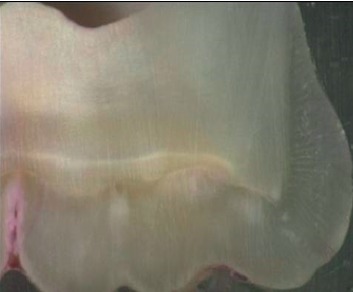
Delimitation of the surface provided for bonding and verification of the presence of a 2.4 mm diameter dentine area.